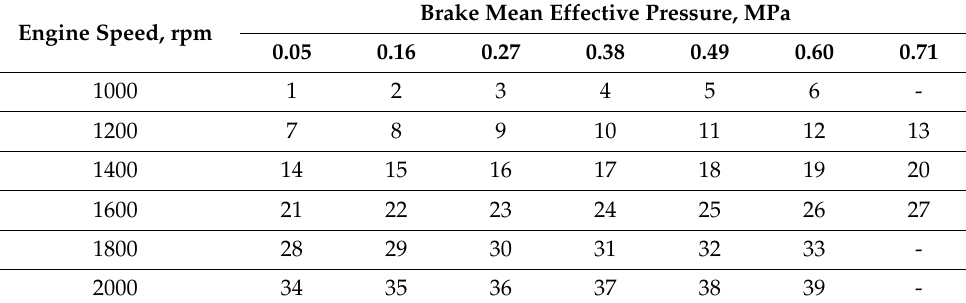
Table 2. Matrix of test measurement